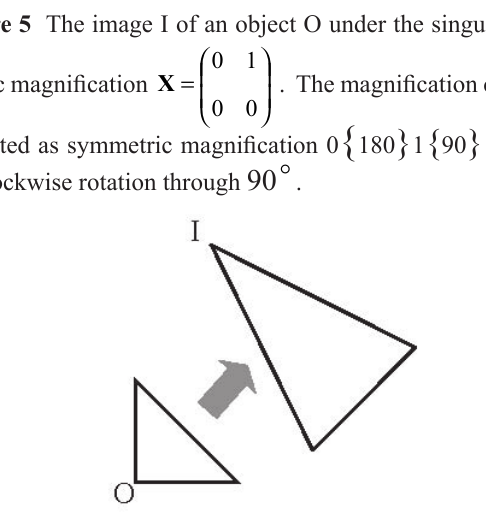
Figure 6 The image I of an object O under asymmetric magnifi - 21    cation  . The magnification is equivalent to symmetric −− 12 magnification 1 { 135 } 3 { 45 } followed by clockwise rotation through 90 ° 30 .